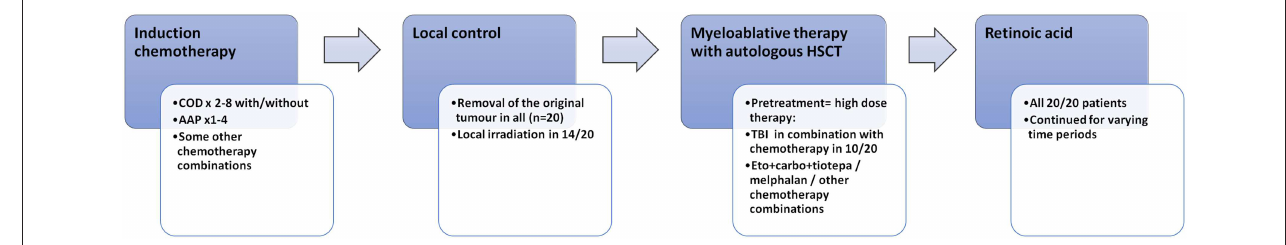
FIGURE 1 | Oncologic treatment in the 20 long-term survivors of high-risk neuroblastoma. COD, cyclophosphamide + vincristine + DTIC; AAP, ciplatin + doxorubicin; HSCT, hematologic stem cell transplantation; TBI, total-body irradiation.